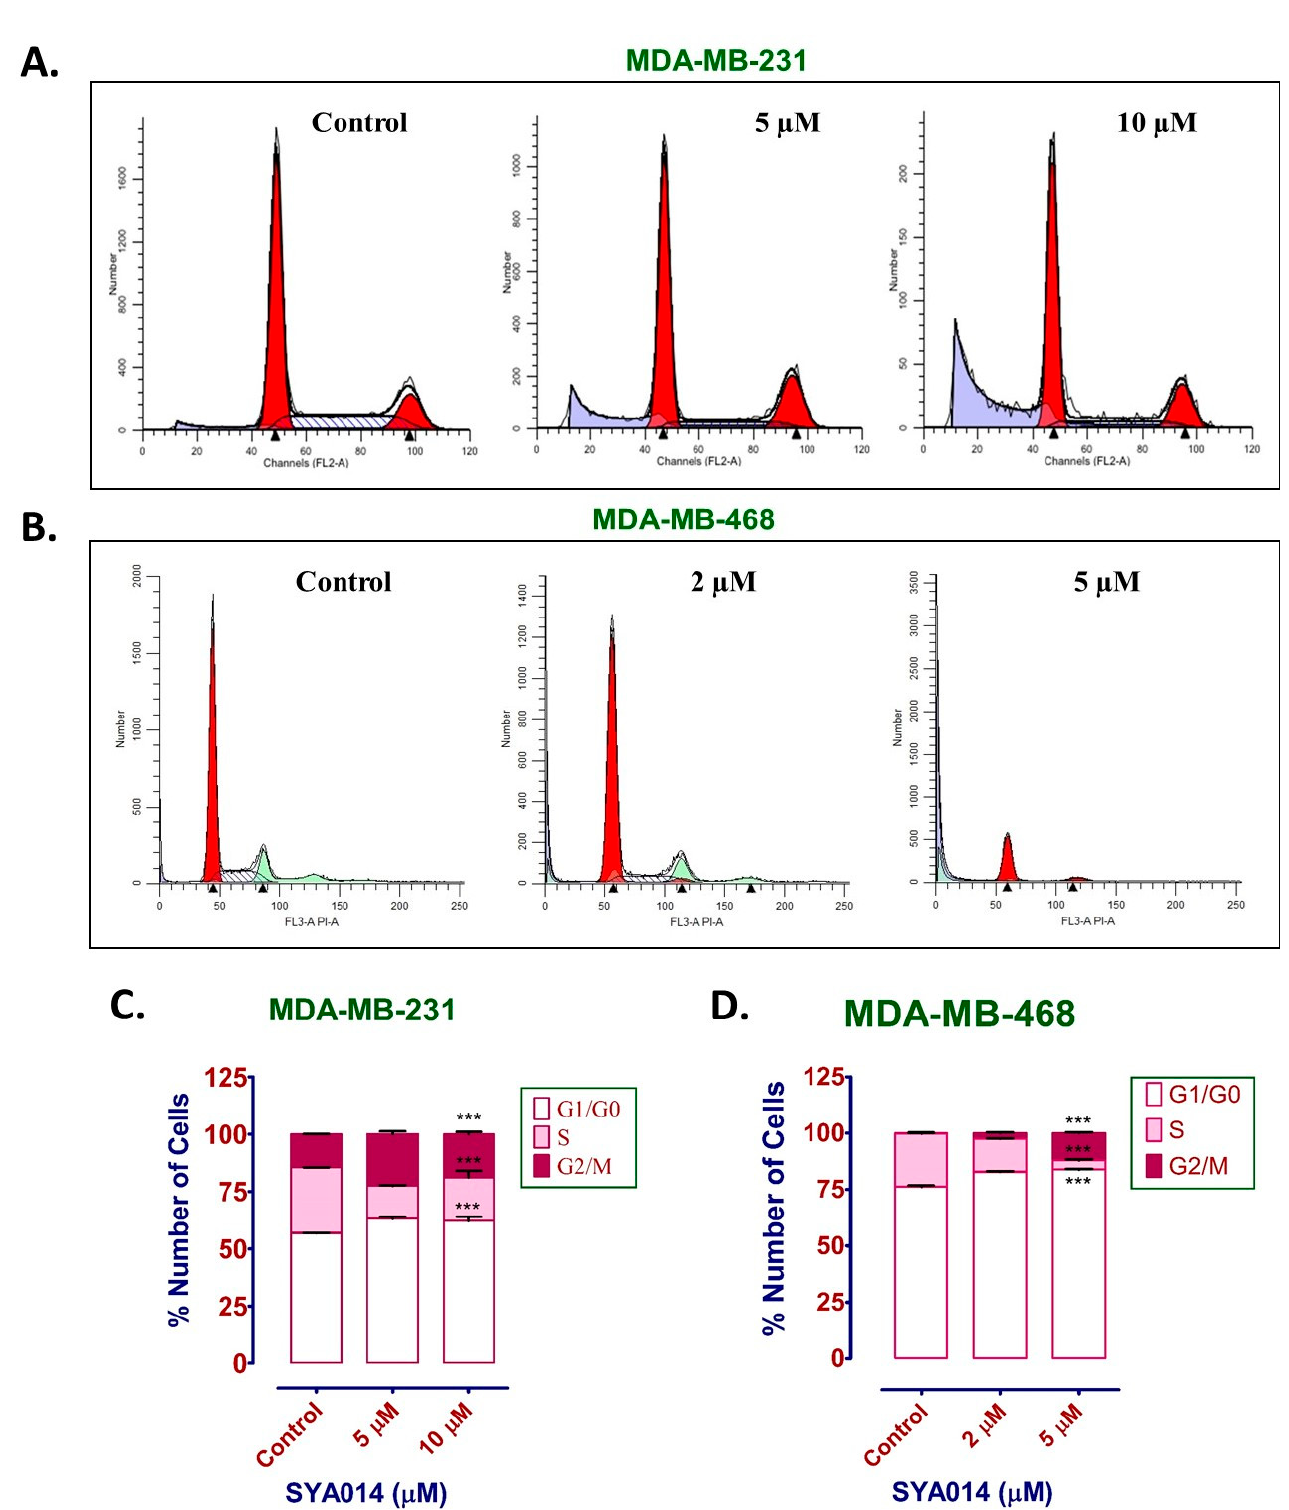
Figure 7. SYA014 arrests cell cycle in TNBC cells. MDA-MB-231 cells ( A ) and MDA-MB-468 cells ( B ) treated with SYA014 at (0–10 µM) and (0–5 µM), respectively, for 48 h, followed by propidium iodide staining and flow cytometry analysis. Quantification of the number of cells at different cell cycle phases for MDA-MB-231 ( C ) and MDA-MB-468 cells ( D ) treated with/without SYA014. *** p < 0.001.